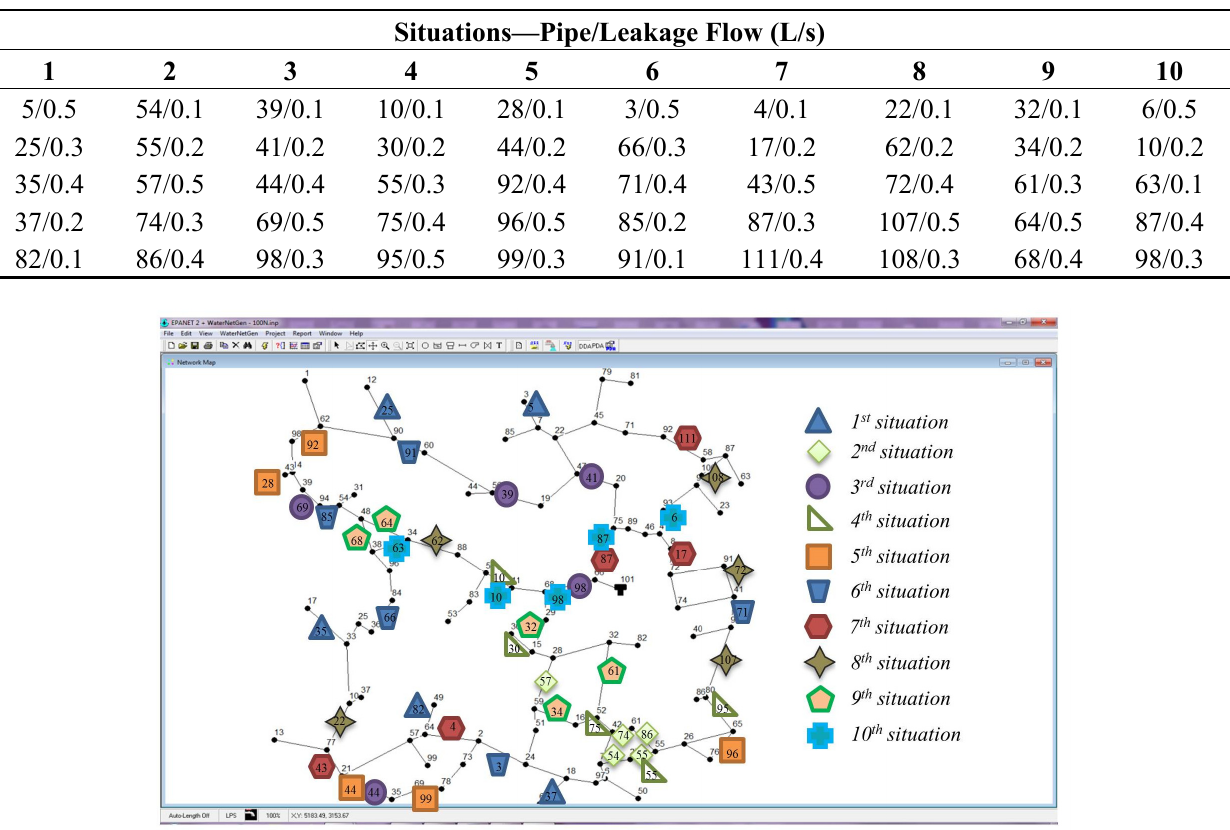
Figure 3. Network layout with ten situations (leakage flow spatial